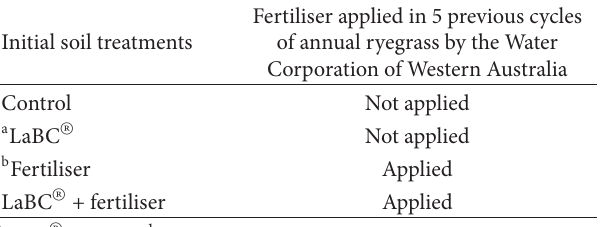
Table 1: Pretreatment details for the establishment of a pasture soil history during 5 cycles of growth of annual ryegrass in a coarse- textured acid soil under glasshouse conditions.